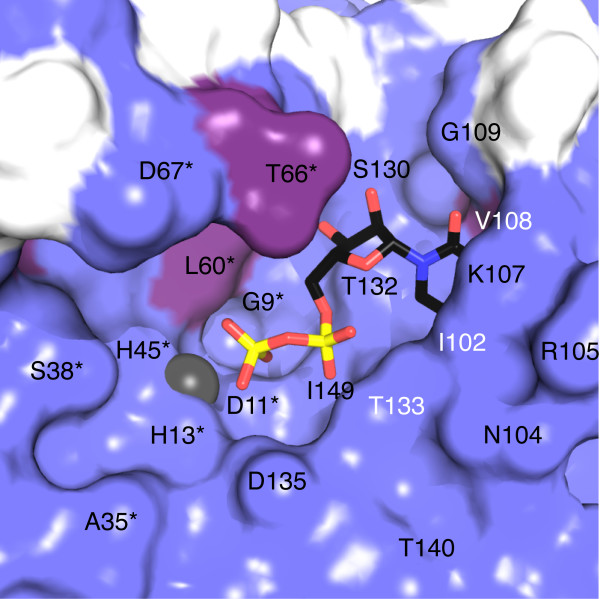
The van der Waals surface of the active site colored according to shared sequence identity with MtIspF. Identical residues are colored slate-blue and similar residues are purple. The active site Zn2+ is a grey sphere, and CDP is shown as a stick model with C atoms in black, N blue, O red, and P yellow. An asterisk indicates contributions from an adjacent subunit.